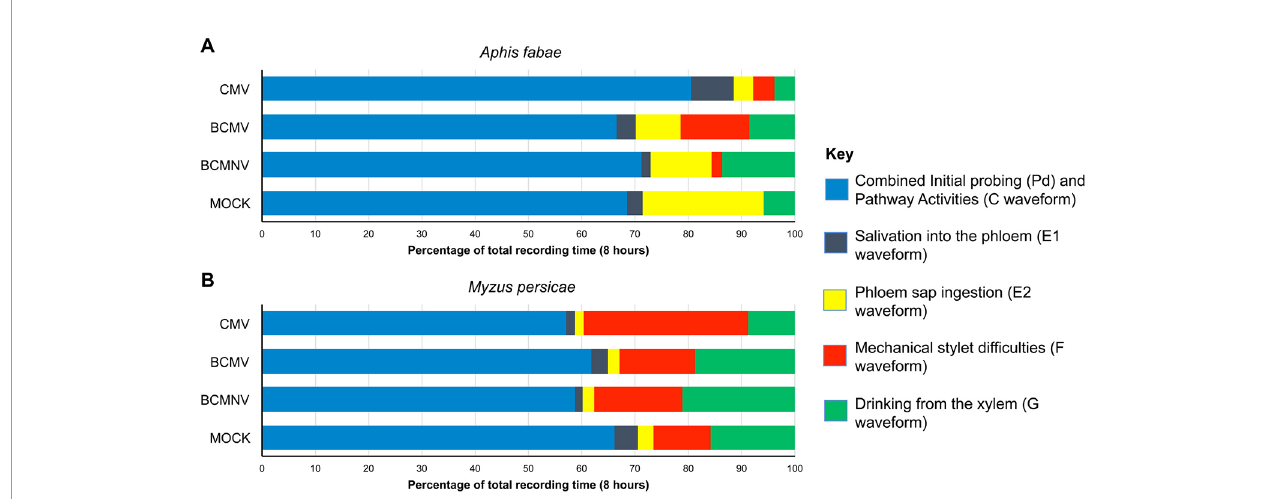
FIGURE 1 | Electrical penetration graph (EPG) monitoring showed that feeding behavior of specialist and non-specialist aphids was modi fi ed on virus-infected bean plants. For both Aphis fabae (A) and Myzus persicae (B) , the combined time engaged in epidermal cell probing and pathway activity accounted for most of the activity recorded over 8 h and this was not markedly altered by the virus infection status of plants, except in the case of A. fabae placed on plants infected with cucumber mosaic virus (CMV), where these activities were increased (A) . Phloem ingestion accounted for a substantial proportion of A. fabae activity on mock- inoculated plants (A) but this was not the case for M. persicae where mechanical stylet dif fi culties and drinking from the xylem occurred, indicating that common bean is a poor host for M. persicae (B) , which is a generalist aphid, rather than a legume specialist like A. fabae . Phloem ingestion by M. persicae was not markedly affected on plants infected with bean common mosaic virus (BCMV), bean common mosaic necrosis virus (BCMNV), or CMV but mechanical stylet dif fi culties increased, especially on CMV-infected plants (B) and for A. fabae phloem ingestion declined on virus-infected plants (A) . Data was collated from EPG recordings of 240 aphids comprising 15 aphids per treatment for each aphid species, i.e., n ( M. persicae ) = 120, and n ( A. fabae ) =